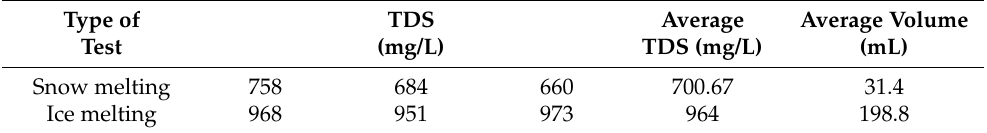
Table 5. Single snow- and ice- melt test